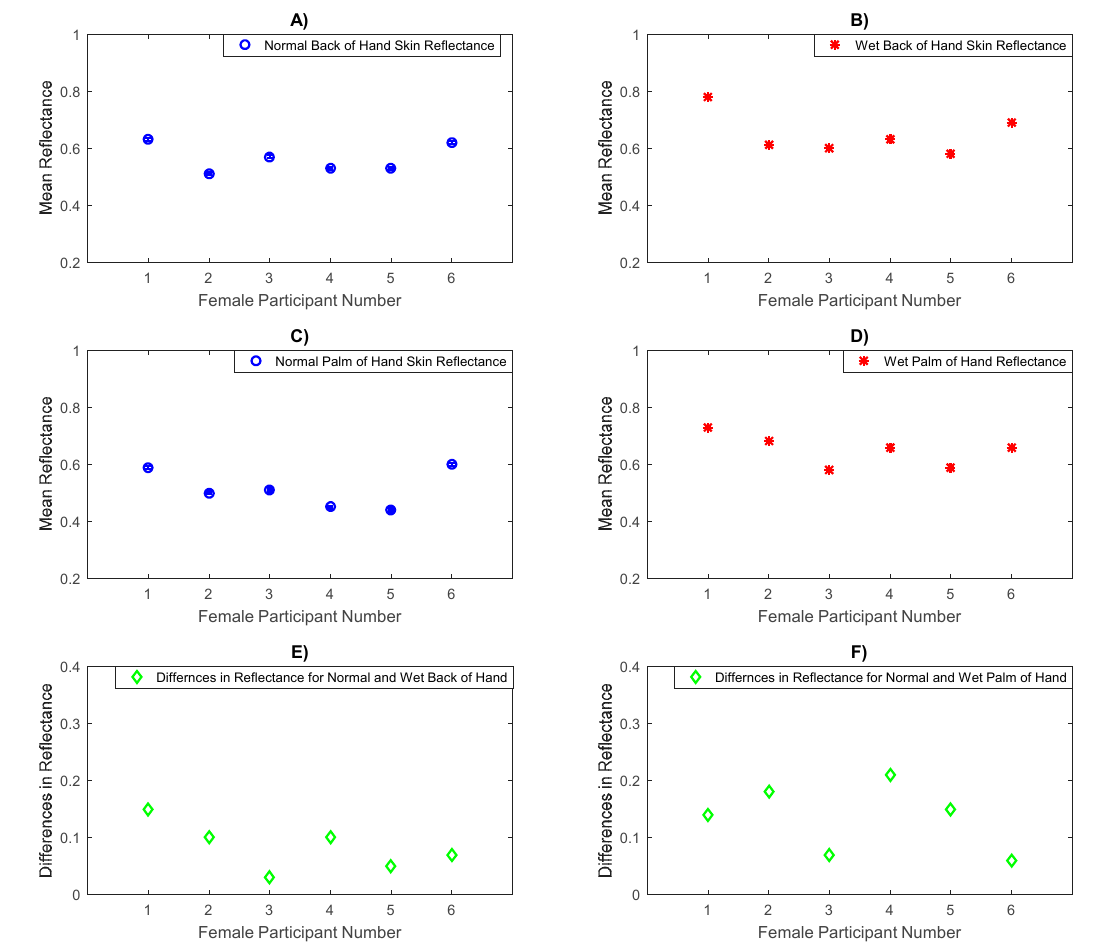
Figure 11. Measurements of human skin reflectance on normal and wet back of hand and palm of hand skin for a sample of 6 female participants. The mean di ff erences in reflectance between the normal ( A ) and the wet back of hand skin ( B ) are in the range of 0.03 to 0.15 as illustrated in ( E ) whereas the mean di ff erences in reflectance between the normal ( C ) and the wet palm of hand skin ( D ) are in the range of 0.06 to 0.21 as illustrated in ( F ).